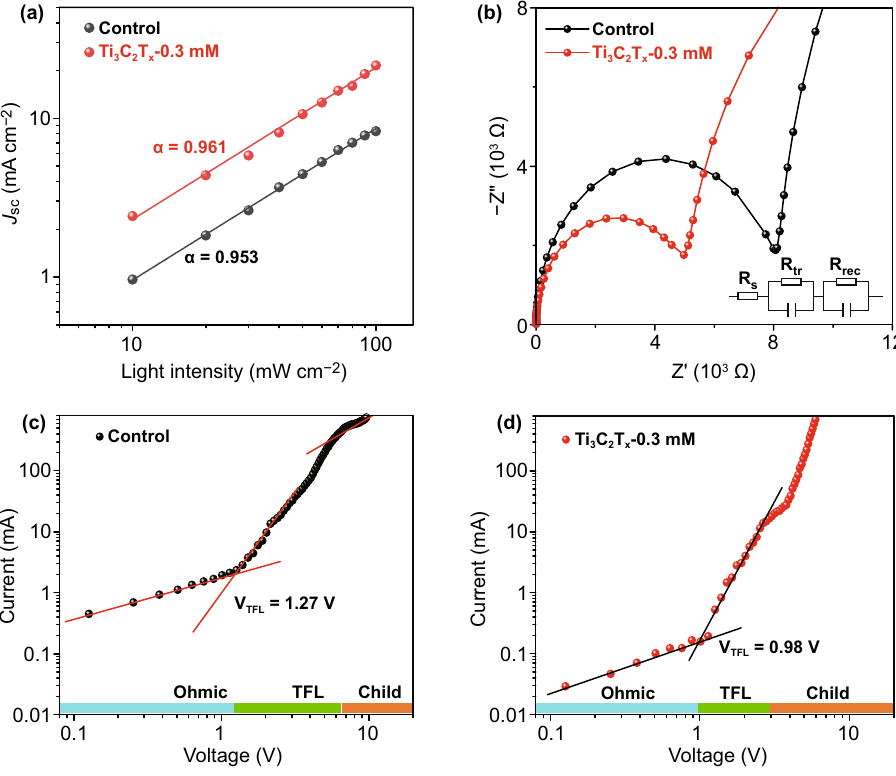
Fig. 5 a J sc versus light intensity and b Nyquist plots of EIS with the equivalent circuit for the control and optimized Ti 3 C 2 T x ‑doping perovskite devices. c , d I–V curves of the electron‑only devices under dark based on the control and optimized Ti 3 C 2 T x